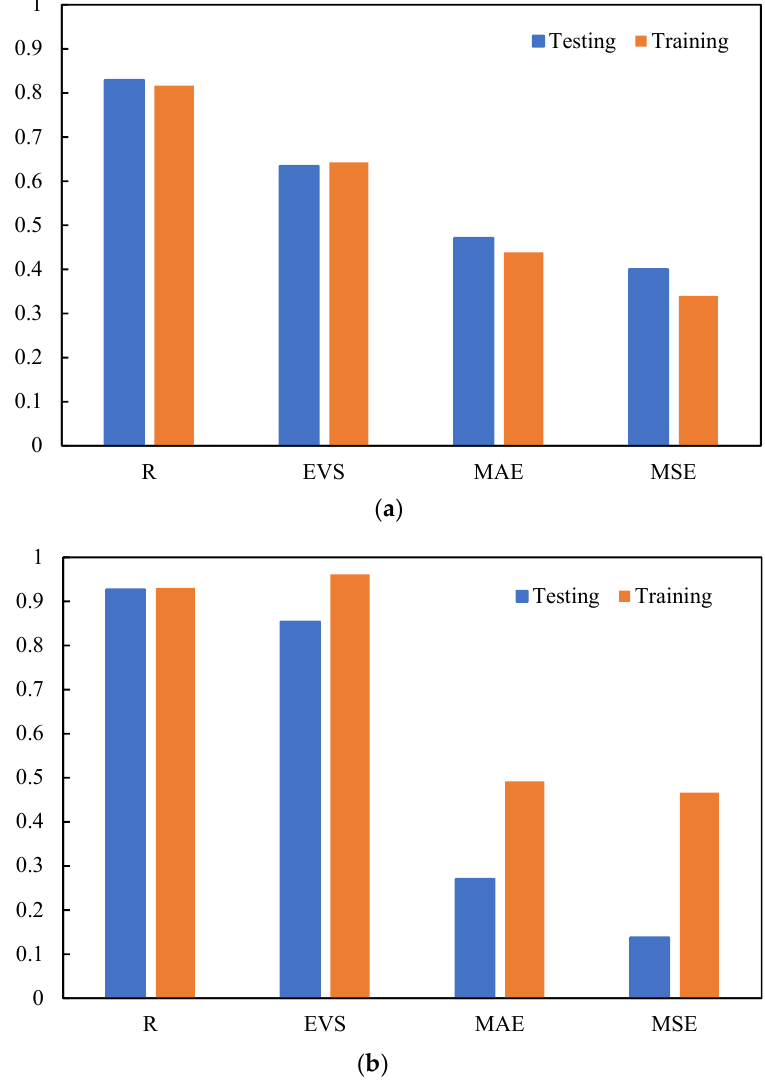
Figure 7. Evaluation of optimized GBDT models on testing and training sets: ( a ) for u p , ( b ) for Q u . The experimental and predicted Q u and u p values were further compared, as shown in Figure 8. The variation trends and the numerical value of Q u and u p were predicted well except for some special cases, such as T33 for u p and T32 for Q u . The R value was 0.941 and 0.913 on the whole datasets of Q u and u p , respectively. Furthermore, Figure